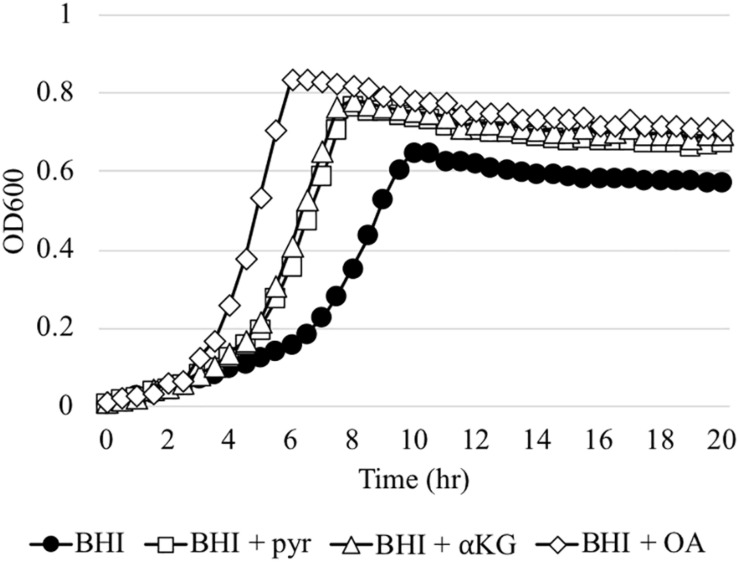
The effect of α-keto-acids on the aerobic growth impairment of the ΔlrgAB mutant strain. The ΔlrgAB strain was aerobically cultivated in plain BHI medium and BHI supplemented by 1 mM exogenous pyruvate (pyr), α-ketoglutarate (αKG), and oxaloacetate (OA). Optical density at 600 nm was monitored every 30 min at 37°C using the Bioscreen C lab system. The results are representative of three independent experiments.